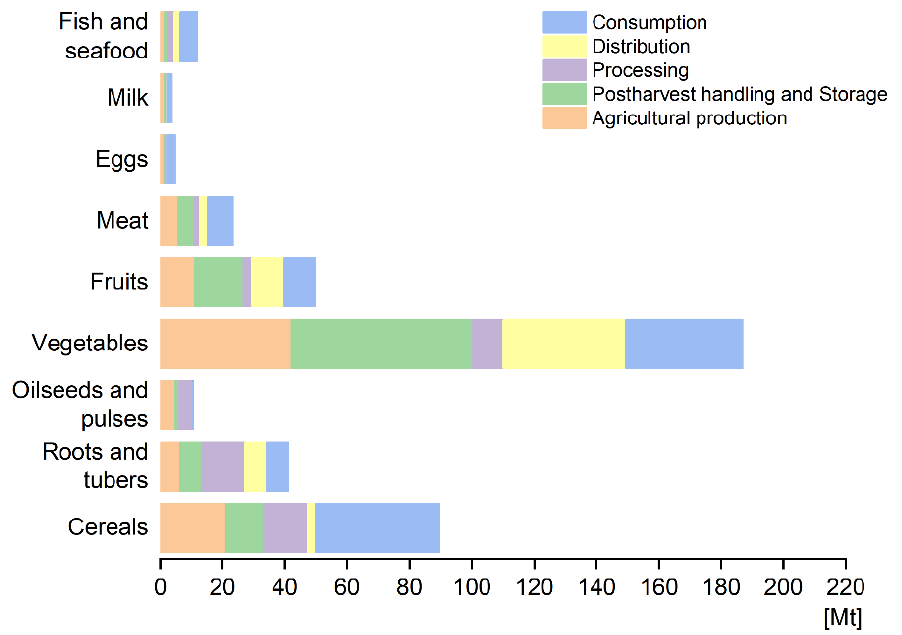
Figure 5. FLW amount calculated along the FSC for each food